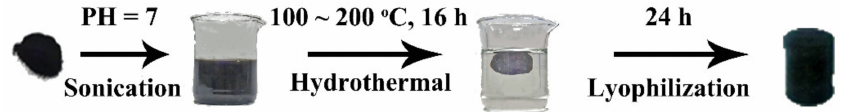
Figure 1. Illustration of the preparation process of the reduced graphene oxide aerogel